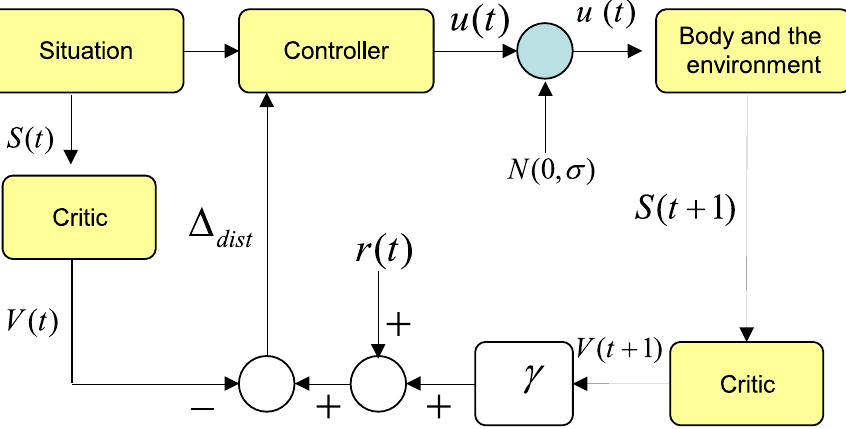
Figure 2. Actor − critic based learning: using the ability to predict to improve the behaviors (control policy). Here is a sleeping policy of the sensor